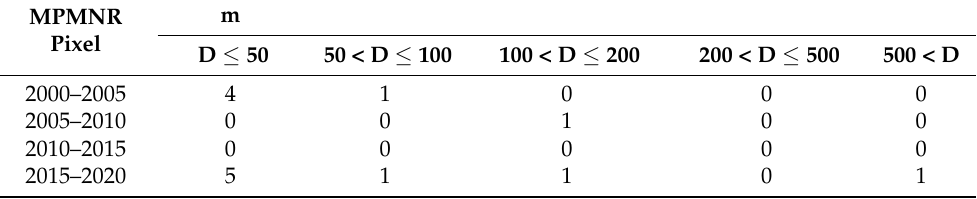
Table A4. The quantity relationship of lost mangrove pixels and the distances between mangroves and driving factors in